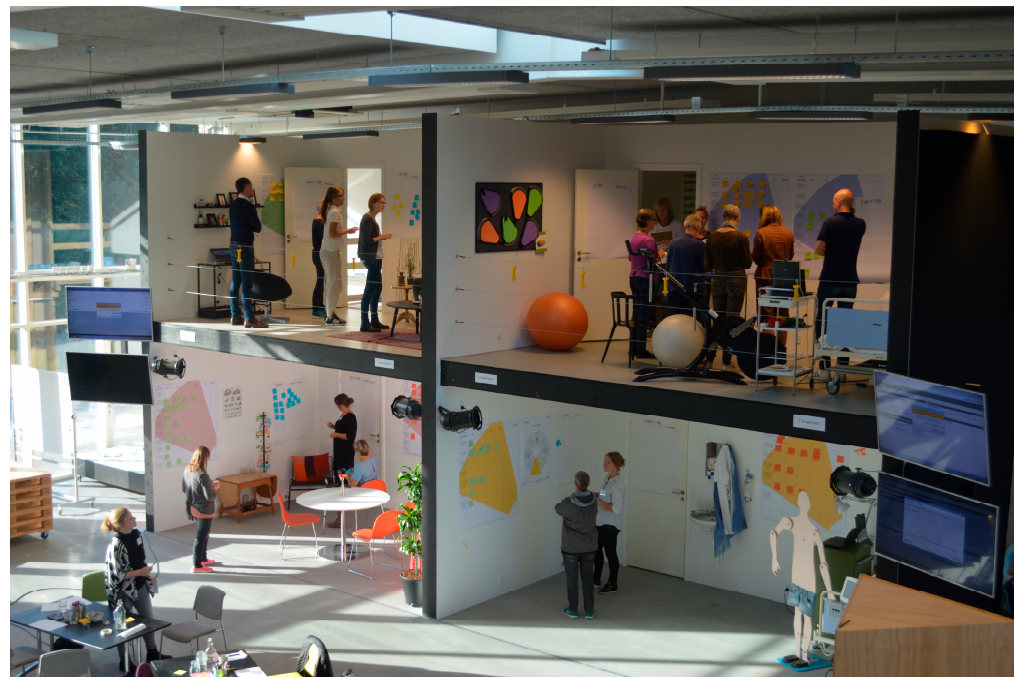
Figure 4. This picture is from the first workshop in a Plug and Play Lab at a Danish Health Innovation Centre. The participants generated ideas and concepts based on the identified needs in the four rooms that represented different situations in the osteoporosis pathway.